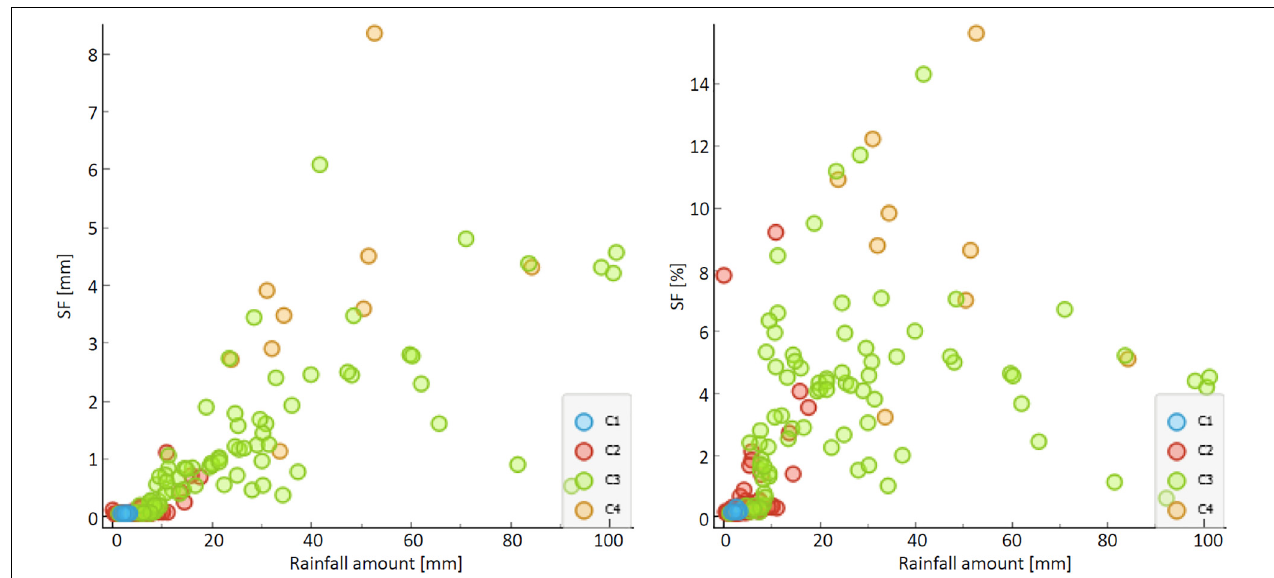
FIGURE 6 | Relationship between the rainfall amount and the corresponding stemflow according to clusters of stemflow